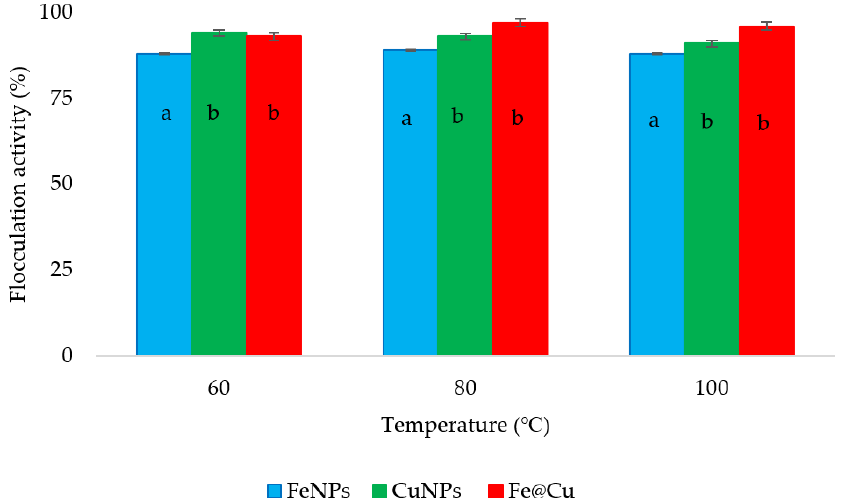
Figure 3. E ff ect of temperature on the flocculation activity at room temperature di ff erent letters (a and b) Figure 3. Effect of temperature on the flocculation activity at room temperature different letters (a and denotes statistical significance at ( p < b) denotes statistical significance at ( p < 0.05).